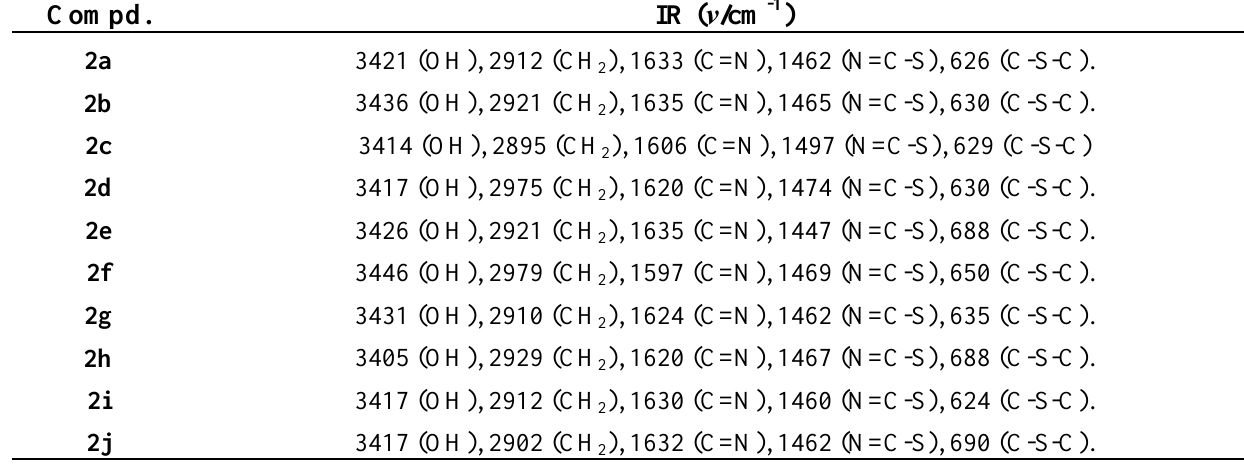
Table 3. IR data of compounds 2a ~ 2j.